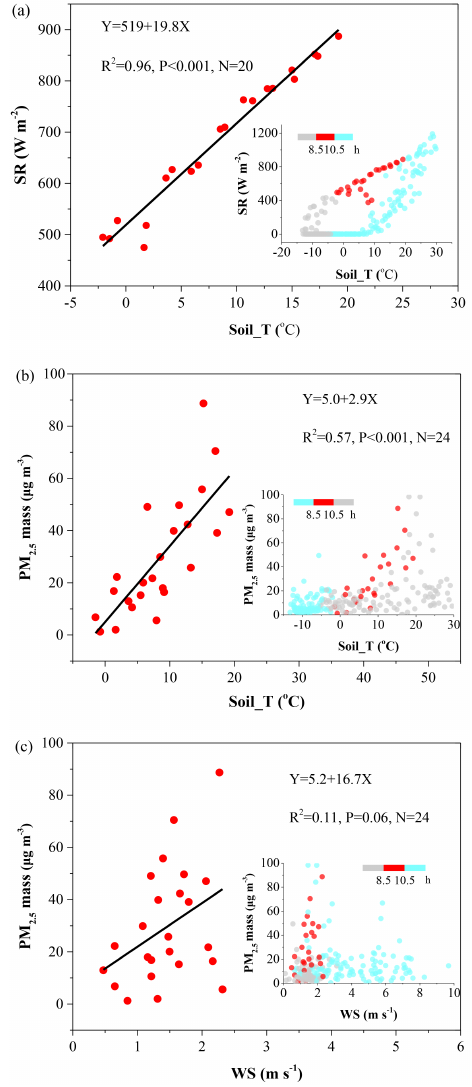
Figure 9. Correlations between SR and soil T (a) , soil T and PM 2 . 5 mass (b) , and WS and PM 2 . 5 mass (c) in the morning (08:30– 10:30LT) at the Ngari station for 6–10 April 2012. The smaller inserts show all recorded points within the measured time frame. Note that the fit line of Fig. 9a is for 6–9 April 2012 because there was a rainfall event ( ∼ 08:00–11:00LT) on 10 April 2012, as indi- cated in Fig. 8. However, even if the dataset for 10 April 2012 is in- cluded, the fit line remains more or less consistent, with R 2 = 0 . 61 and P <0.001. The local time (LT) and a 30min mean were